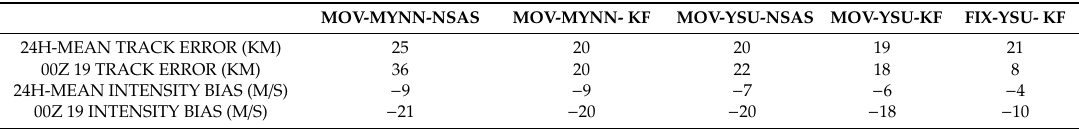
Figure 8. Dominica area WRF 0.8 km simulations from 00Z 18 September initialization: ( a ) Track map and (lower) maximum wind for five experiments with inner nest-3 vs. NHC observed, ( b ) WRF simulated wind (m / s) at 00Z 19 September 2017 for FIX-YSU-KF. Operational model forecasts from 00 Z 18 September 2017 vs. NHC observed: ( c ) Maximum wind speed (m / s) and ( d ) track map. Table 2. Model results for the Dominica landfall experiments.